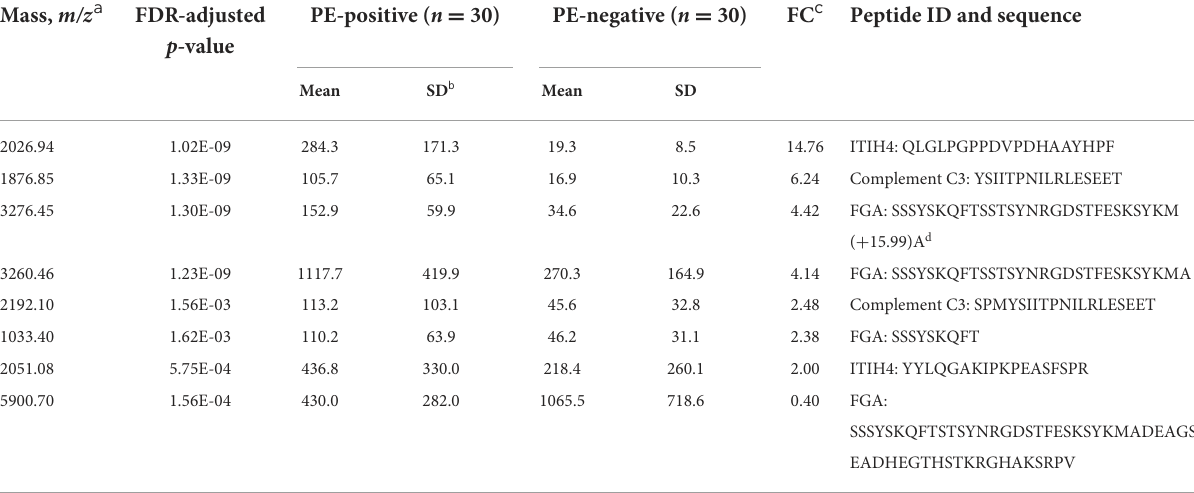
TABLE 2 Significantly differentially expressed mass peaks with peptide identification by LTQ-Orbitrap-MS. Mass, m/z a